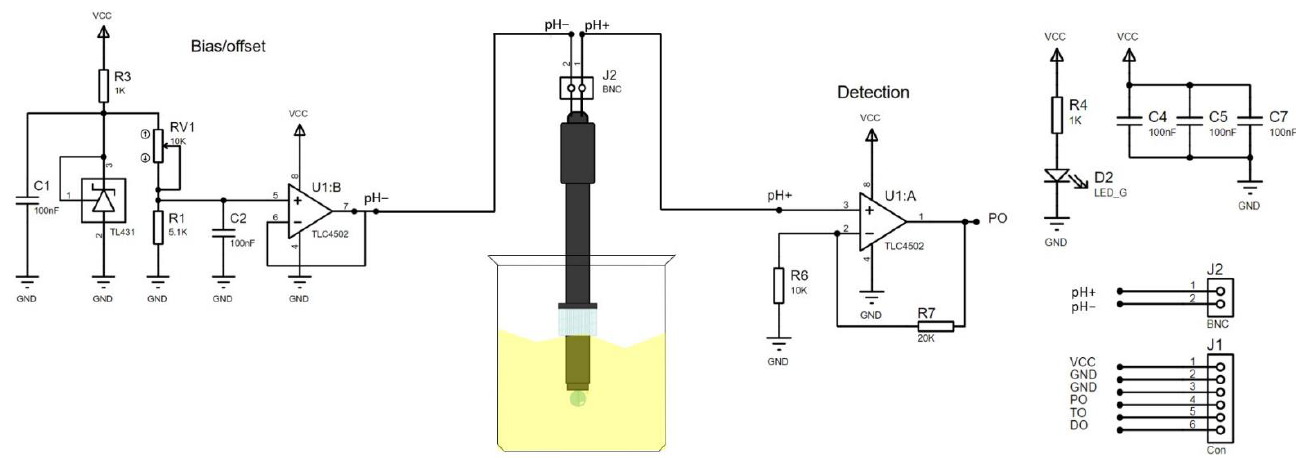
Figure 3. The signal conditioning stage is constructed by implementing an offset section, followed by a detection/amplification stage. The sensor is coupled using an array of precision op-amps in buffer and non-inverting amplifier configurations to ensure adequate performance. and non-inverting amplifier configurations to ensure adequate